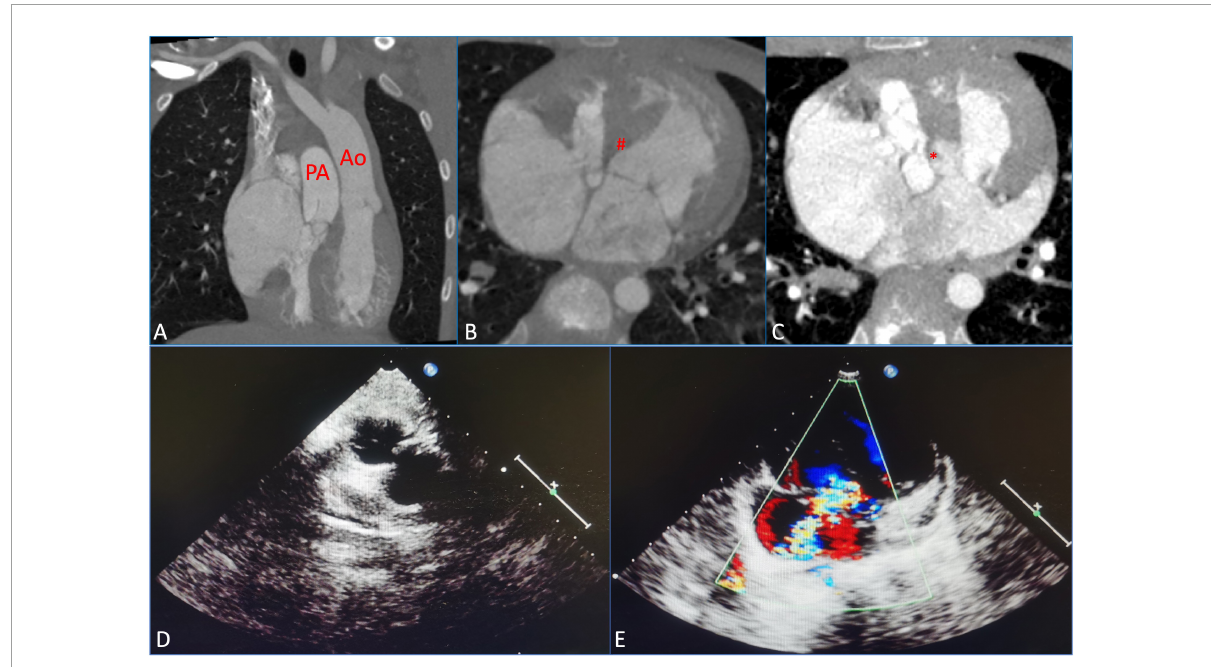
FIGURE1 Preoperative measurements using computed tomography, angiography, and echocardiography were assessed before the surgical repair. (A) Congenitally corrected transposition of the great arteries (ccTGAs). (B) Membranous ventricular septal aneurysm (MVSA). (#) Represents MVSA. (C) Atrial septal defect (ASD). ( ∗ ) Represents ASD. (D) Severe pulmonary stenosis (PS). (E) Severe tricuspid regurgitation (TR). PA, pulmonary artery; Ao, aorta.